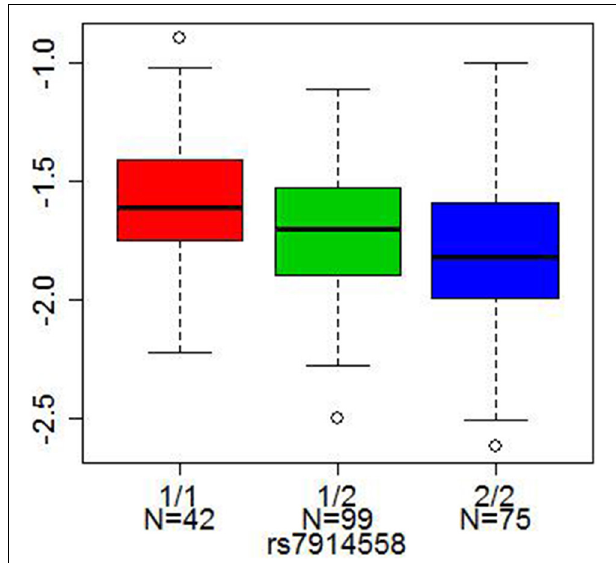
FIGURE 3 | Cis-association of a SNP with DNA methylation. The x axis represents three genotypes of each SNP (1/1 red, 1/2 green, and 2/2 blue, where 1 = A or T allele and 2 = G or C allele), and the y axis represents DNA methylation levels. The lines in the bar graph indicate the median, and the bars (whiskers) represent the minimum and maximum values after the removal of the outliers. rs7914558 was associated with DNA methylation status at cg15439196 in the CNNM2 gene (Bonferroni corrected p = 1 . 74 × 10 − 2